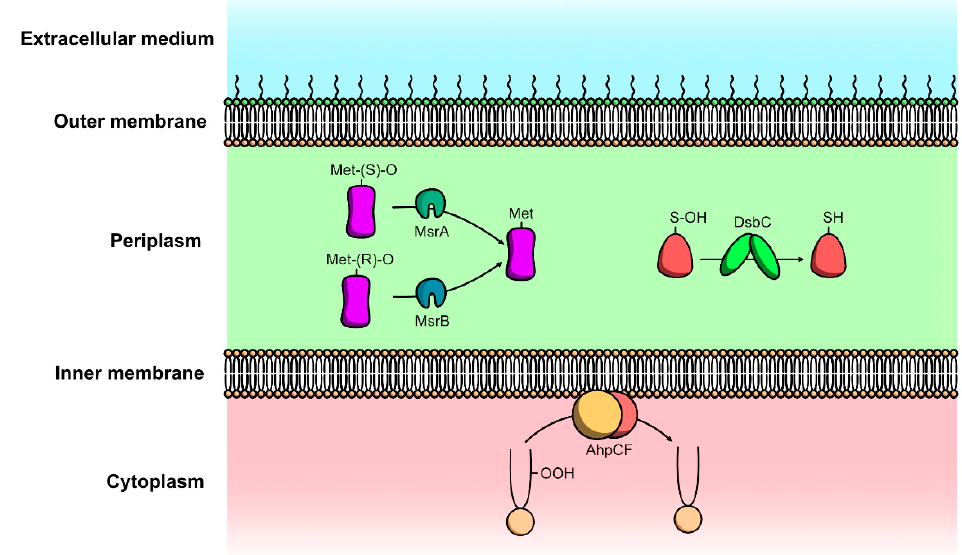
Figure 3. Envelope repair systems of Gram-negative bacteria against oxidative and nitrosative stresses induced